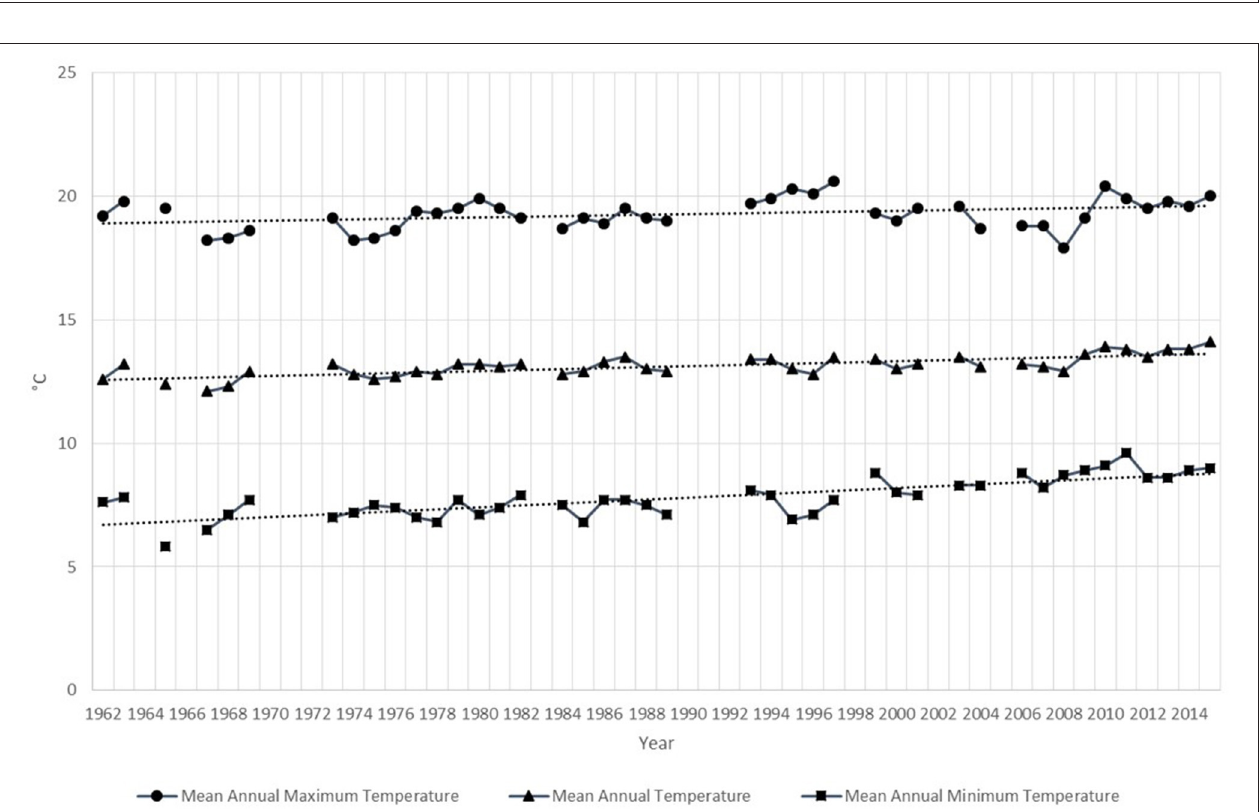
Count circle (Table S1). The accumulated number of